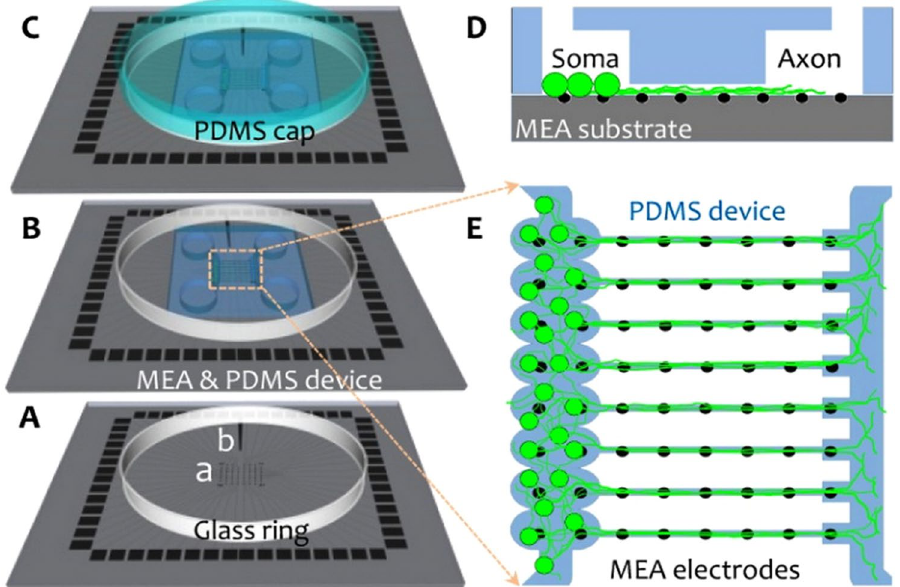
Figure 1. Coupling a PDMS microchannel device with a MEA. ( A ) MEA device with 59 recording electrodes (a) and one counter electrode (b). A glass ring (r = 30 mm, height = 5 mm) attached to the MEA substrate retains the cell culture medium. ( B ) The PDMS microchannels were aligned with the MEA electrodes and cells were seeded through one of the 4 device openings. ( C ) After seeding the cells and rinsing the whole